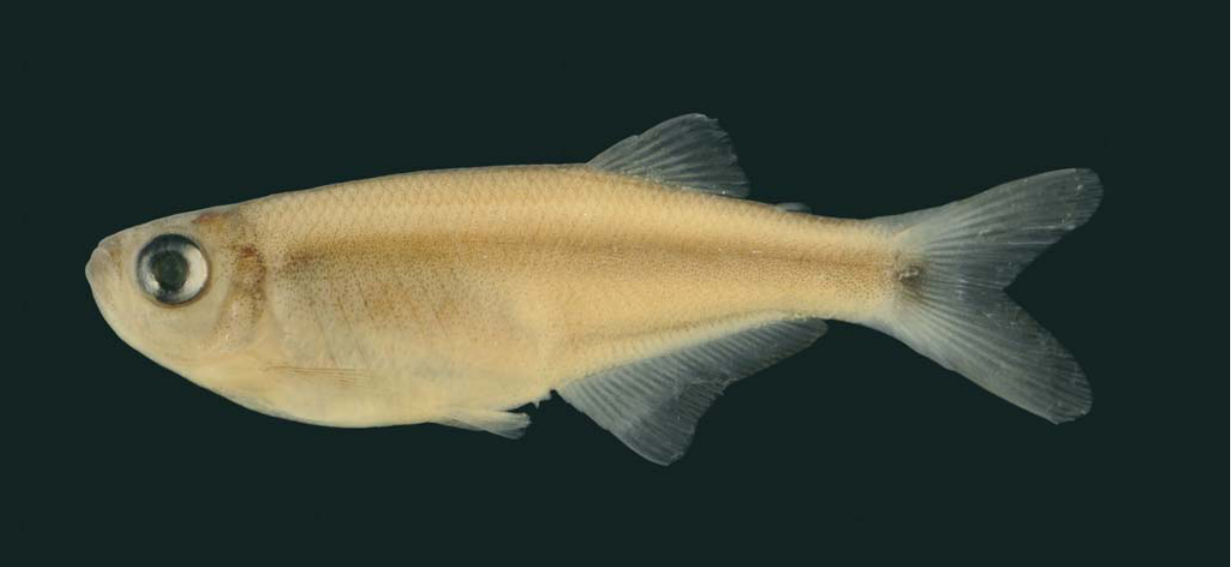
Fig. 64. Mimagoniates sylvicola , adult female, MZUSP 93873, Brazil, Bahia, município of Canavieiras, stream between Ouricana and Santa